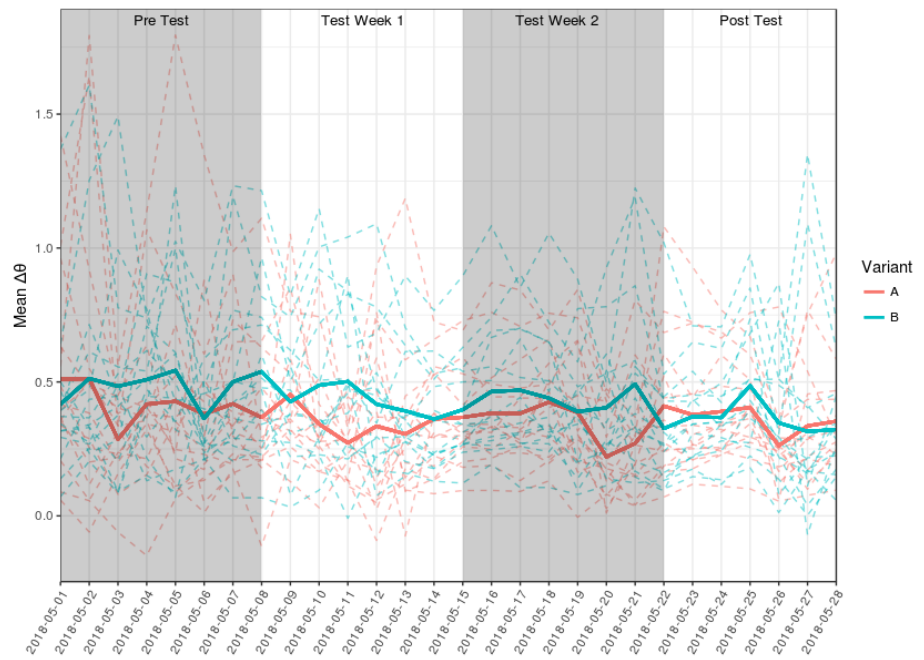
Figure 5. Mean daily ∆ θ per base garden domains (dotted), mean ∆ θ (solid). The treatment condition average seems consistently above the control condition average, indicating a faster development in ability on